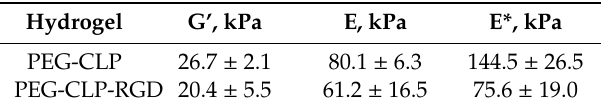
Figure 1. Spectroscopic characterization of the synthesized collagen-like peptide (CLP), CLP-integrin- binding motif arginine-glycine-aspartate (RGD), and the respective polyethylene glycol (PEG)- peptide conjugates. ( a ) NMR spectra of the peptides; blue arrows indicate arginine ( δ 3.19), and serine ( δ = 3.83) peaks from CLP-RGD. ( b ) Circular dichroism (CD) spectra of the CLP peptide and the same peptide conjugated to 8-arm-PEG. ( c ) CD spectra of the CLP-RGD peptide and the same peptide conjugated to 8-arm-PEG. ( d ) Schematic explaining the principle PEG-peptide hydrogel synthesis. The peptides first were conjugated to a multi-arm PEG template, which facilitated their self-assembly in a solution. The formed architectures were then locked by further crosslinking the conjugates to obtain a self-supporting and optically transparent material. Table 1. Elastomechanical properties of crosslinked peptide hydrogels. Shear storage modulus (G’) was estimated by rheology and was used to calculate the Young (elastic) modulus (E). Direct and detailed probing of the Young moduli (E*) was performed by the atomic force microscopy nanoindentation technique, and the values for PEG-CLP compared to PEG-CLP-RGD had a statistically significant di ff erence, p ≤